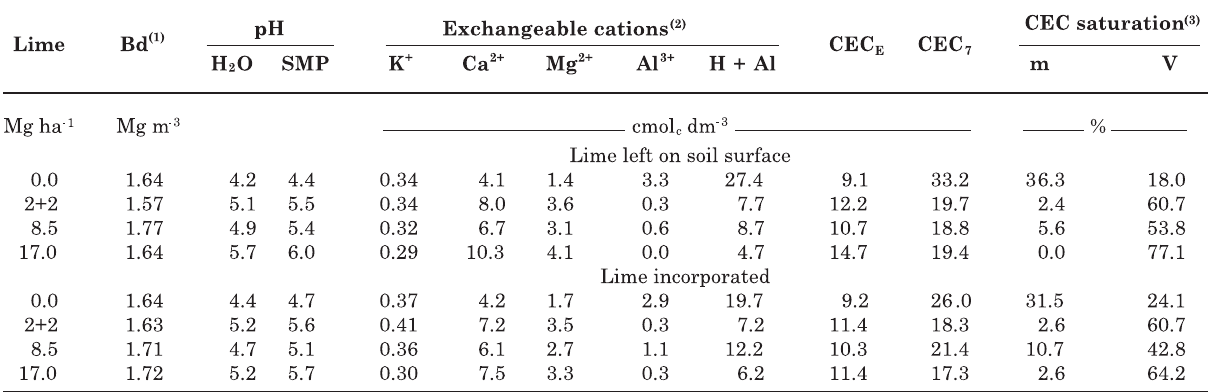
Table 1. Chemical attributes and soil bulk density (Bd) for the 0.00–0.05 m soil layer under a no-till system